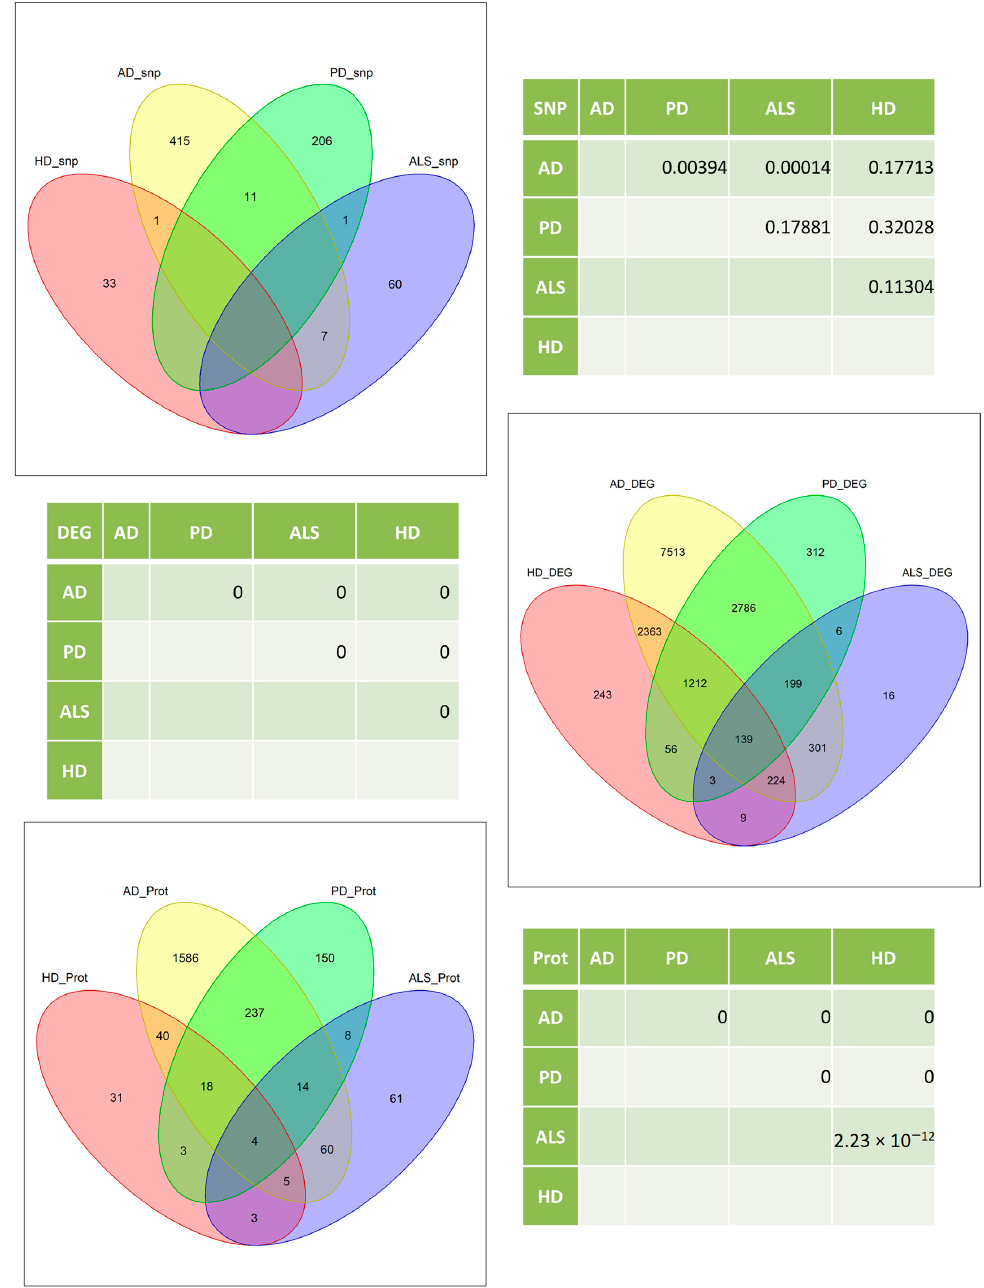
Figure 3. Venn diagrams and hypergeometric test results for the overlap between significant single nucleotide polymorphism (SNP)-trait associations (genomic level) and significantly differentially expressed genes on the transcriptomic (middle) and proteomic (bottom) levels for AD, PD, HD and ALS. All tested intersections show highly significant enriched numbers of overlapping genes for the transcriptomic and proteomic data. The genomic data show significantly enriched numbers of overlapping genes for the AD-PD and AD-ALS intersections.